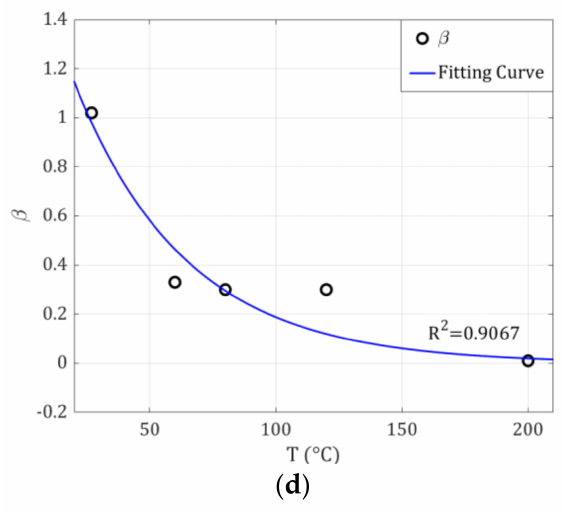
Figure 7. Hysteresis loop of a real NdFeB alloy sample measured in [30] and modeled at different temperatures ( a ), the corresponding functions f ( ω t ) ( b ), and the values of α ( c ) and β ( d ) as functions of the